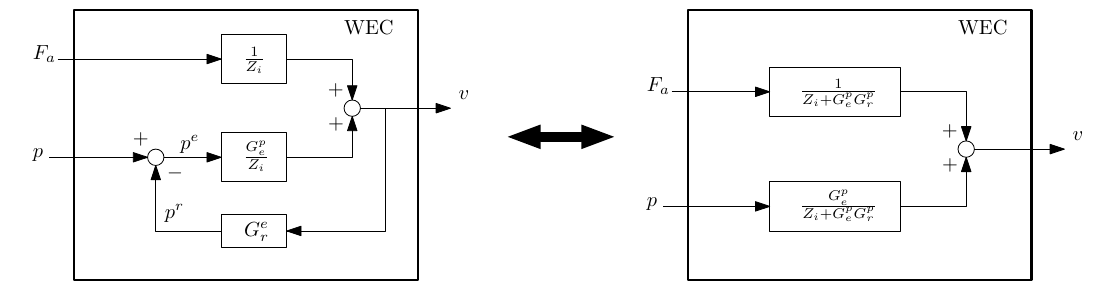
Figure 33. Bock diagram of the MISO